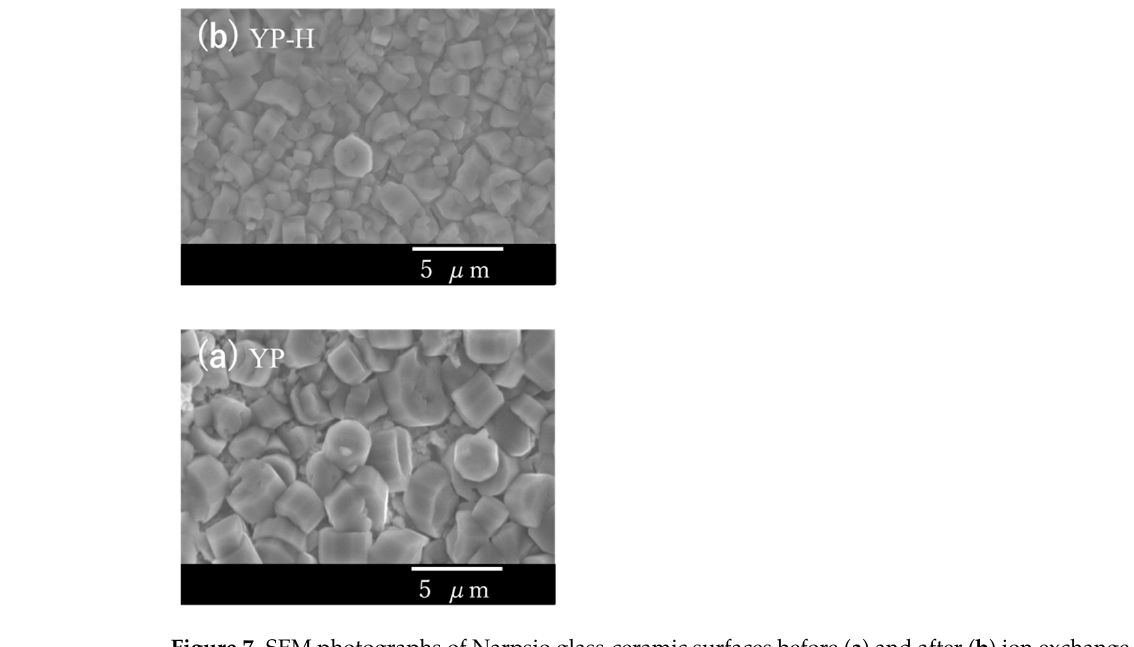
Figure 7. SEM photographs of Narpsio glass-ceramic surfaces before ( a ) and after ( b ) ion exchange at 25 °C using 0.01 M HCl aqueous solution.